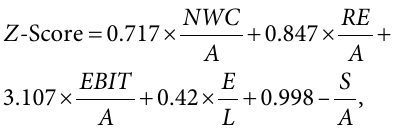
Table 2. Altman Z -Score evaluation table (source: authors based on Altman & Hotchkiss, 2006) Z -Score Value Healthy enterprise Z > 2.9 Grey zone 1.23 < Z < 2.9 Unhealthy enterprise Z <